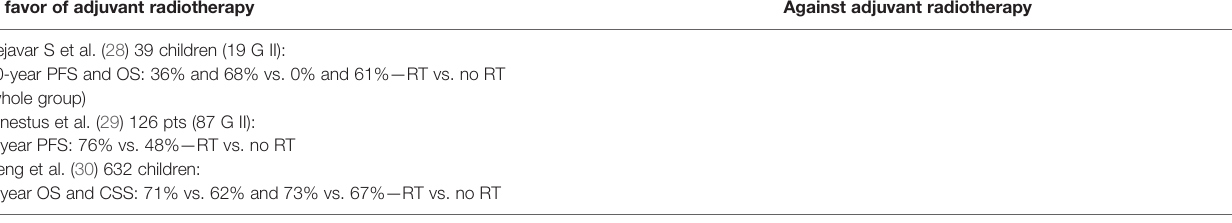
TABLE 5 | Studies of patients with spinal grade II ependymomas with regard on the impact of adjuvant radiotherapy. In favor of adjuvant radiotherapy Against adjuvant radiotherapy Oh et al. (31) 348 adults (337 GII); literature review: 5- and 10-year PFS: 98% and 98% vs. 65% and 50% vs. 45% and 30% — GTR vs. STR + RT vs. STR Rodriguez et al. (18) 2,408 pts (2,132 spine and brain G II); SEER database: not reported OS/PFS with respect to RT